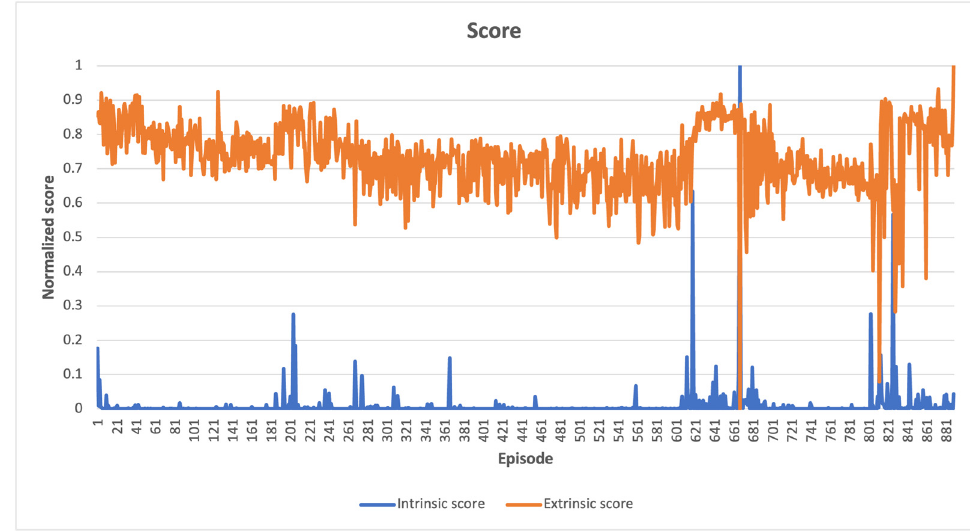
Figure 6. LunarLander-v2 learning scores, high intrinsic values coupled with low extrinsic values around episodes 661 and 800 indicate control failure during exploration of unknown states.